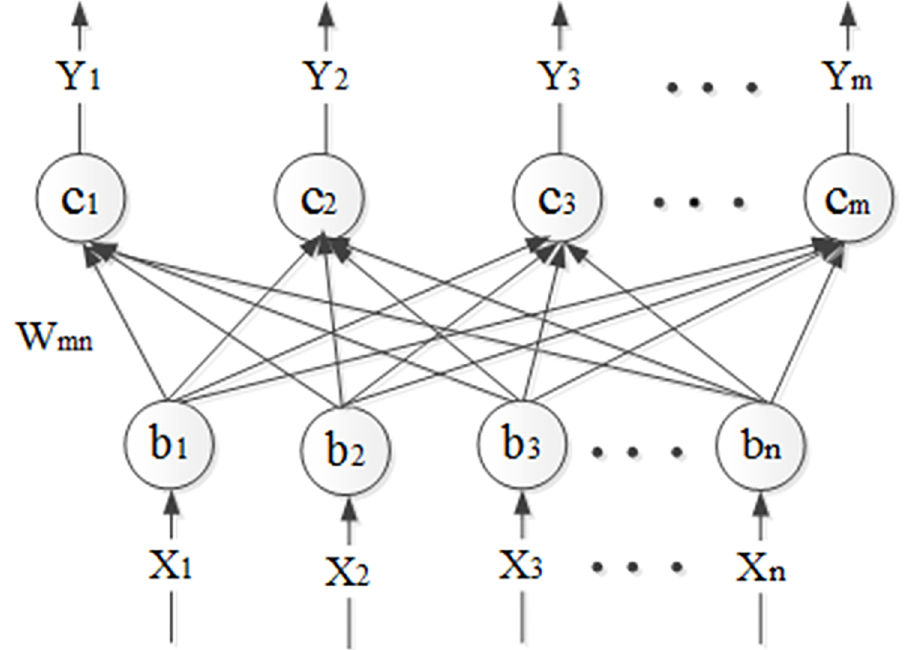
Fig 5. Network topology of Restricted Boltzmann machine. The RBM network consists of two layers, namely, the visiblelayer and the hiddenlayer. The neuronsof the two layers are fully connected, while the neuronsin the same layer are independentof one another. The two layers satisfy the Boltzmanndistribution law. The network topology of the RBM is shownin Fig